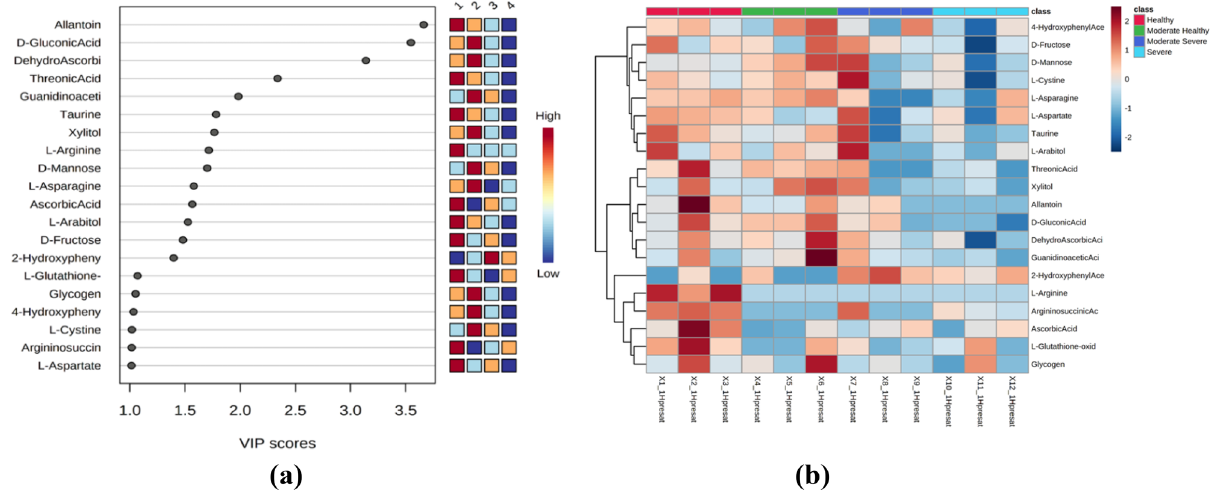
Figure 3. ( a ) The results of the analysis of significant compounds using PLS-DA analysis on all disease severity indices. ( b ) Heatmap visualization results on all disease severity levels. The red color on the heatmap indicates a relatively high concentration, and the blue color indicates a relatively low concentration. The x-axis in the figure represents each sample in this analysis, the top x-axis represents disease severity index class, the right y-axis represents each identified compound, and the left y-axis represents the grouping of compounds by